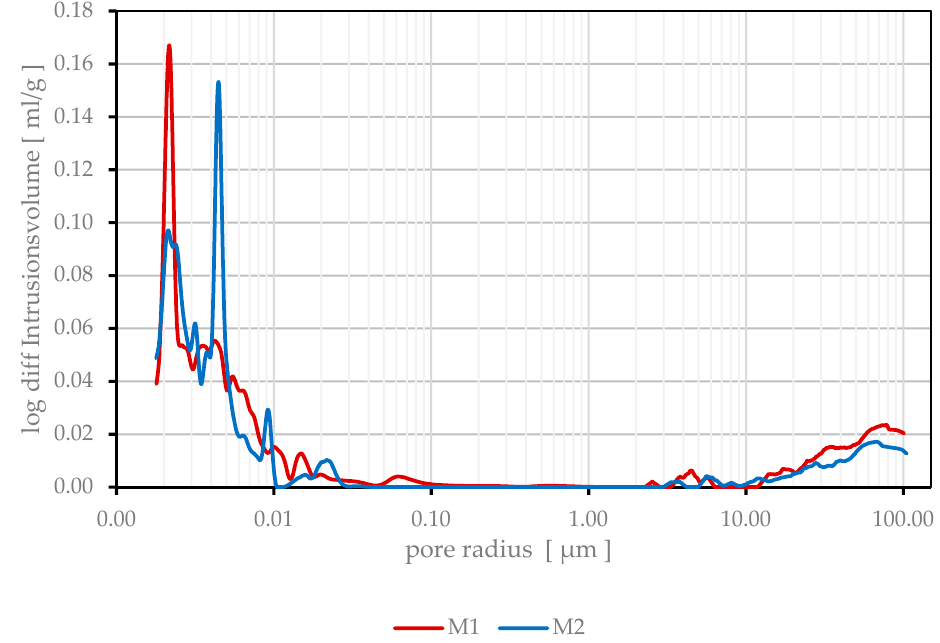
Figure 4. Pore size distribution of the two selected laboratory mixtures.